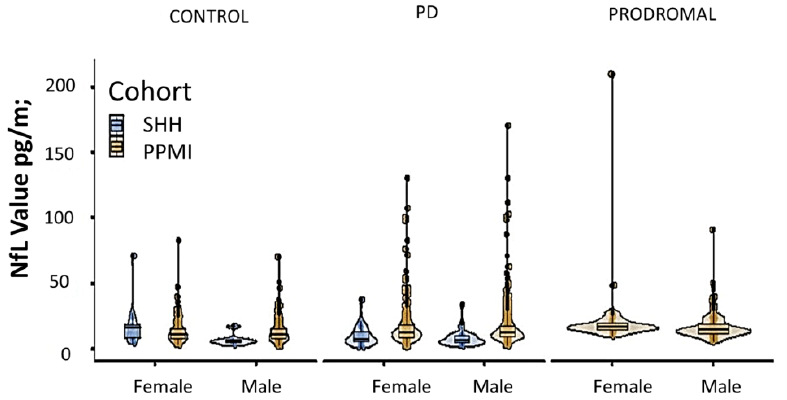
Figure 2. Violin plot with imbedded boxplots showing the blood NfL levels in control, PD, or prodromal cases from the SHH and PPMI cohorts, stratified based on gender. SHH, Shuang Ho Hospital; PPMI, Parkinson’s Progression Markers Initiative.